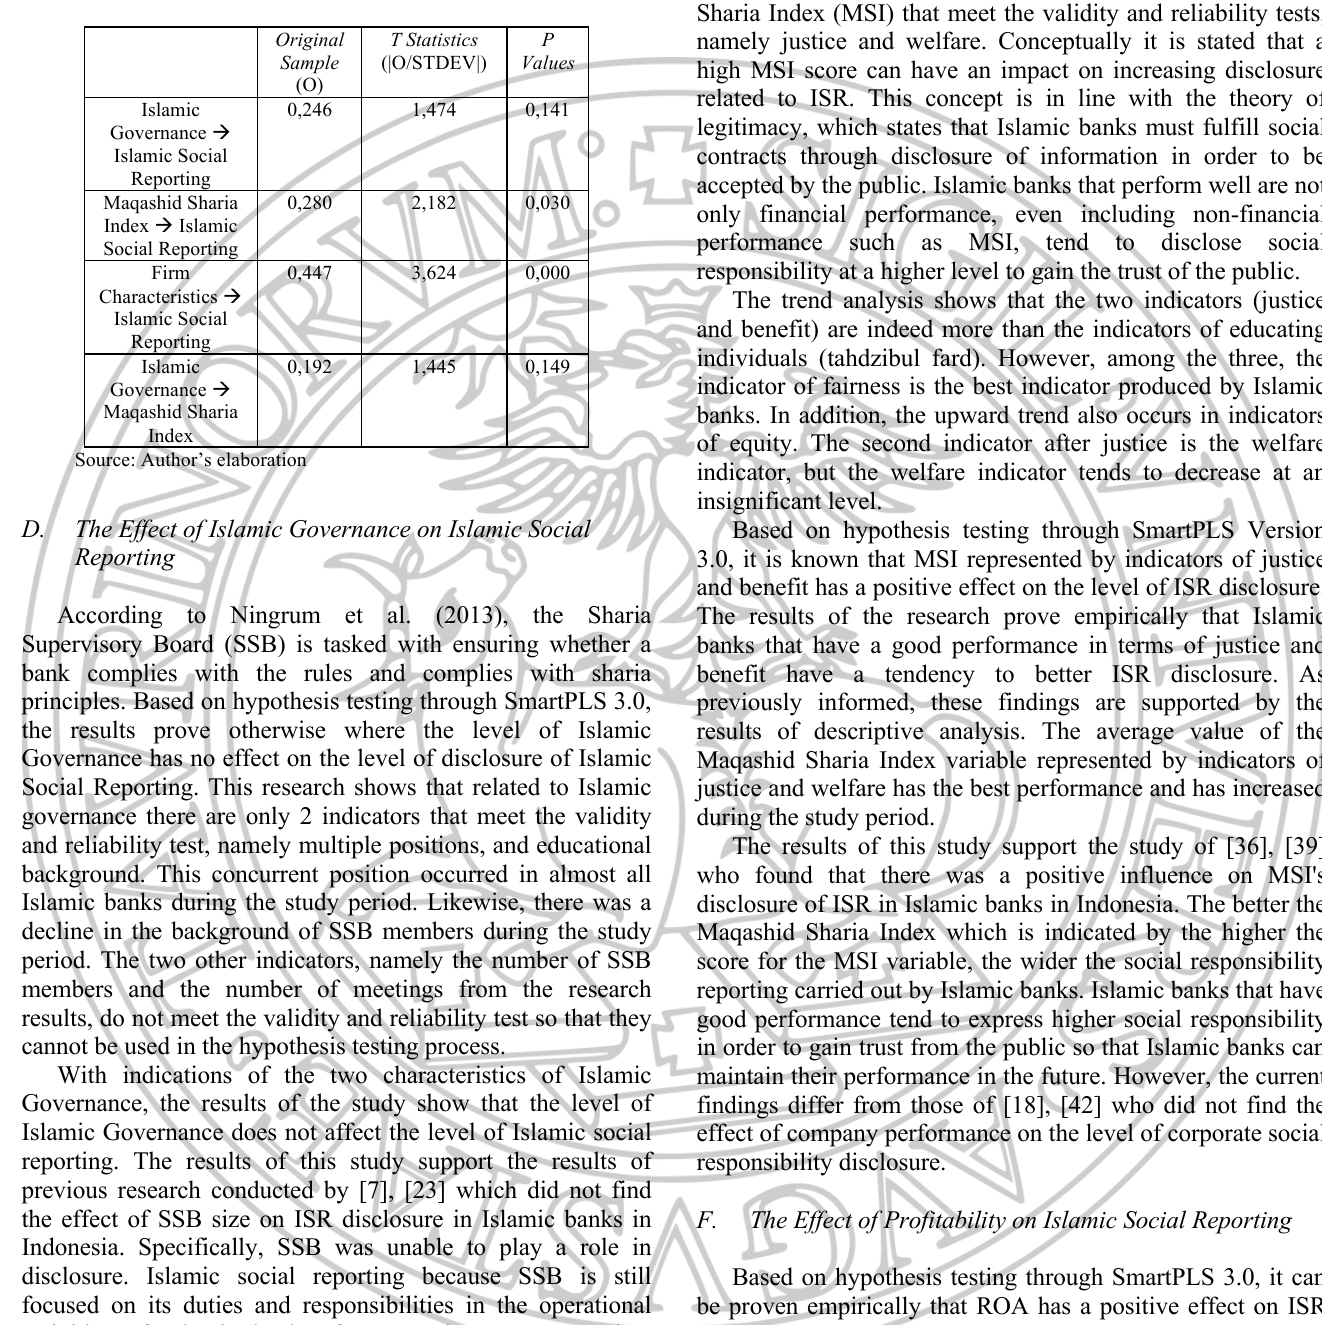
TABLE 4. HYPOTHESIS TESTING